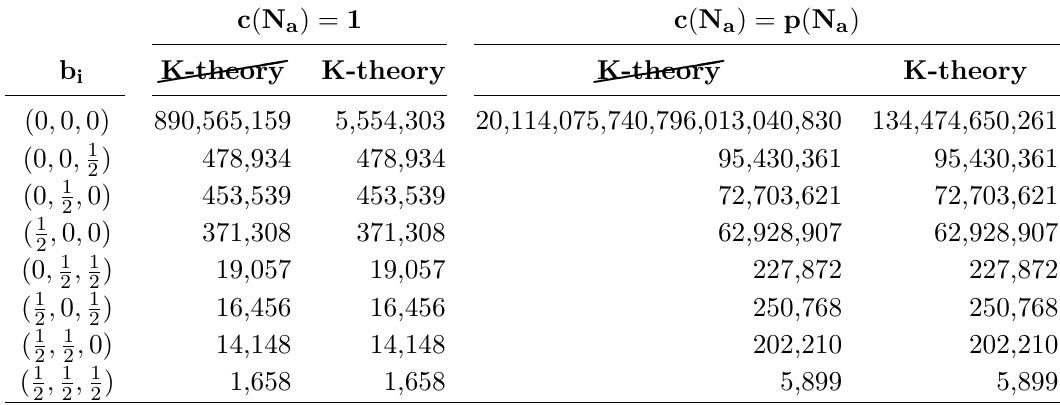
Table 1. Exact number of vacua with 0 < b U 0 ≤ b U 1 ≤ b U 2 ≤ b U 3 for T = 8 , both counting schemes and with K-theory charge cancellation ignored and imposed.